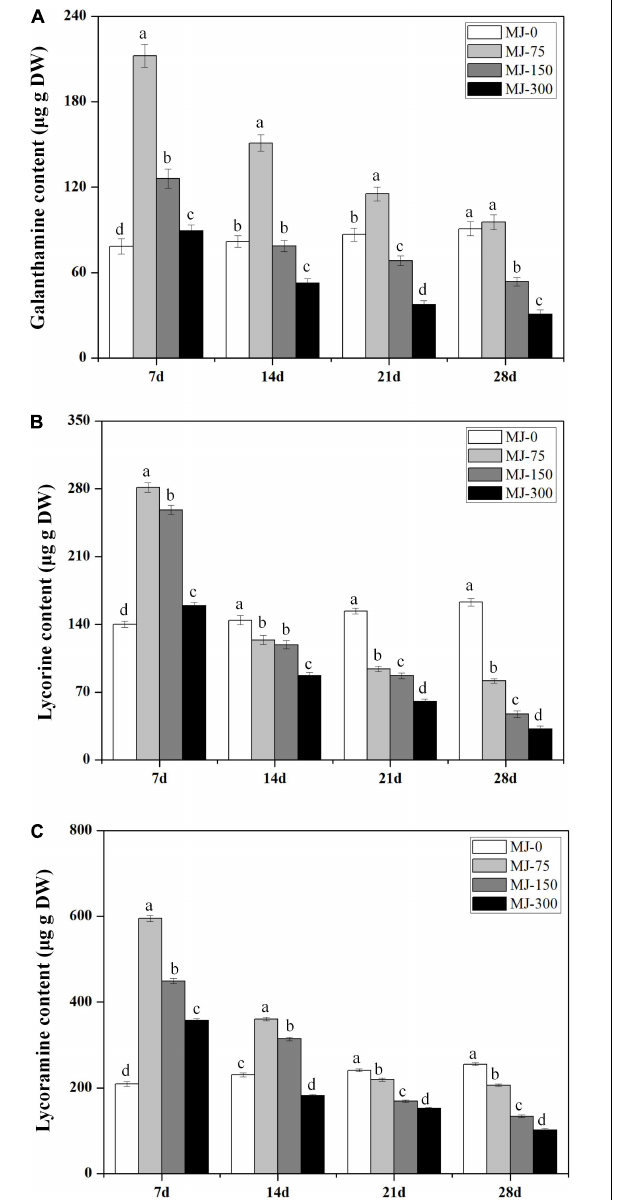
FIGURE 3 | The time course alkaloids accumulations in the seedlings of L. longituba treated with different concentrations of MeJA. (A) The time course Gal accumulations in the seedlings of L. longituba treated with different concentrations of MeJA. (B) The time course Lyc accumulations in the seedlings of L. longituba treated with different concentrations of MeJA. (C) The time course Lycm accumulations in the seedlings of L. longituba treated with different concentrations of MeJA. Error values indicate the standard deviation (SD). Least-significant difference test (LSD, p < 0.05) was used to compare the means. Different letters represent significant differences between groups ( N = 3, p < 0.05).